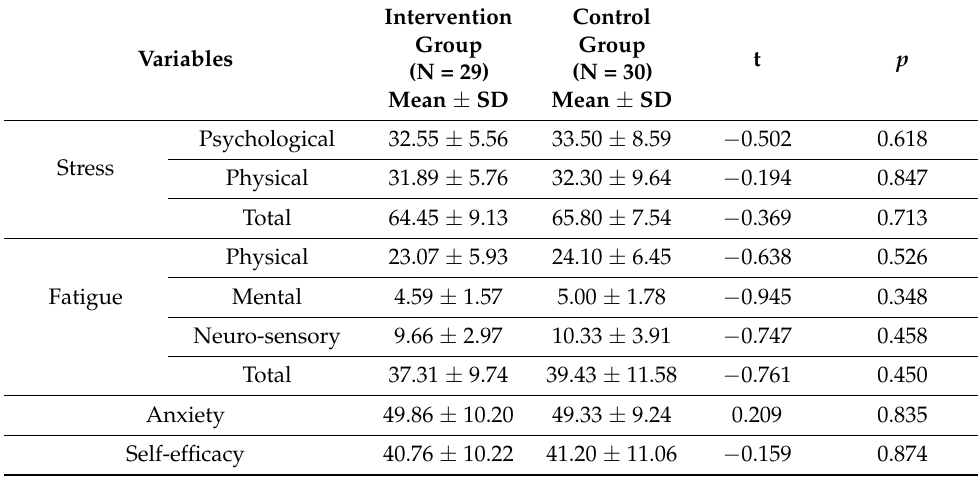
Table 2. Levels of stress, fatigue, anxiety, and self-efficacy of shiftwork nurses, and homogeneity at pre-intervention.